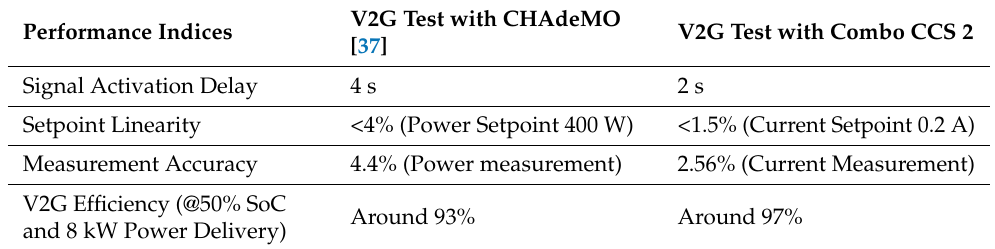
Table 9. The V2G testing result between CHAdeMO and Combo CCS Type 2 charger connector